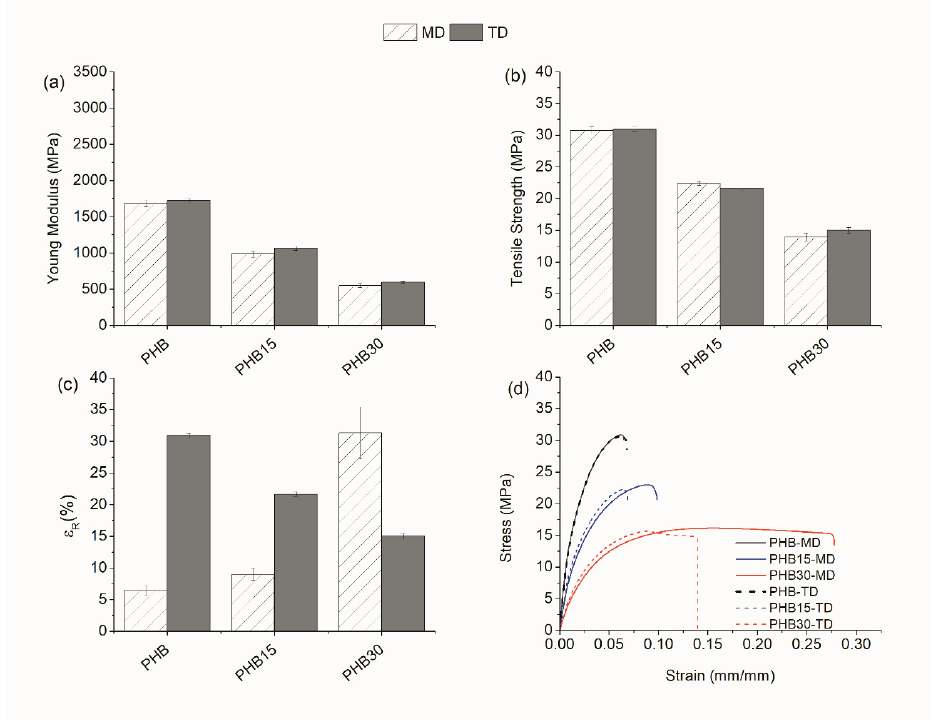
Figure 7. Mechanical properties at 0 days in MD and TD: ( a ) Modulus of elasticity, ( b ) tensile strength, ( c ) strain at break, and ( d ) representative stress vs. strain curves.